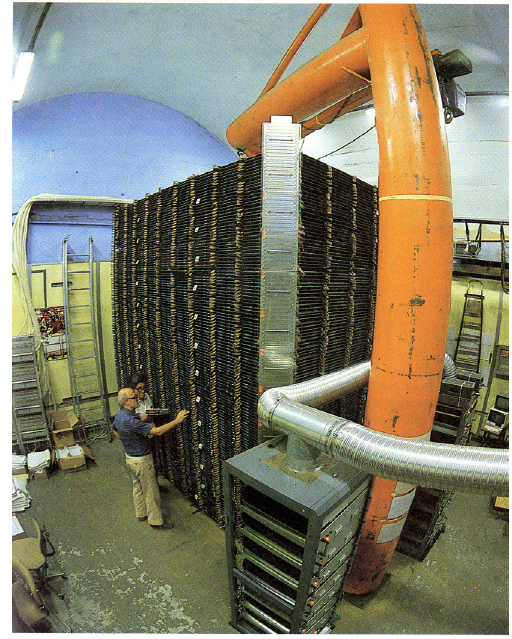
Figure 4. Nusex experiment.